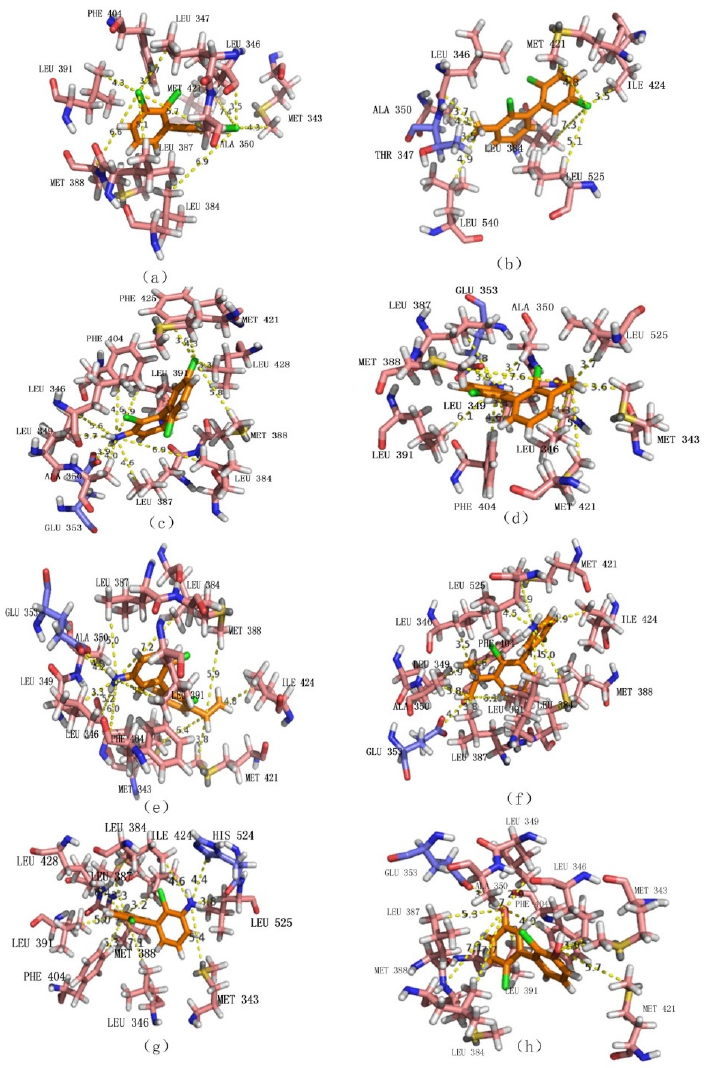
Figure 5. Docking conformation of PCB-44 molecule ( a ) and the modified novel molecule 3-methyl-PCB-44 ( b ), 3-amino-PCB-44 ( c ), 3-methyl-5 ′ -amino-PCB-44 ( d ), 3-vinyl-5 ′ -amino-PCB-44 ( e ), 3-isopropyl-5 ′ -amino-PCB-44 ( f ), 3-amino-5 ′ -amino-PCB-44 ( g ) , and 3-hydroxy-5 ′ -hydroxy-PCB-44 ( h ) docked to hER α (PDB ID: 2Q6J), respectively. (Orange rod-shaped structure represents the PCB-44 molecule; blue and pink rod-shaped structures represent hydrophilic and hydrophobic amino acid residues at the binding site, respectively; yellow dashed line represents the distance between the hydrophobic substituent and the hydrophobic amino acid residue of PCB-44 molecules).